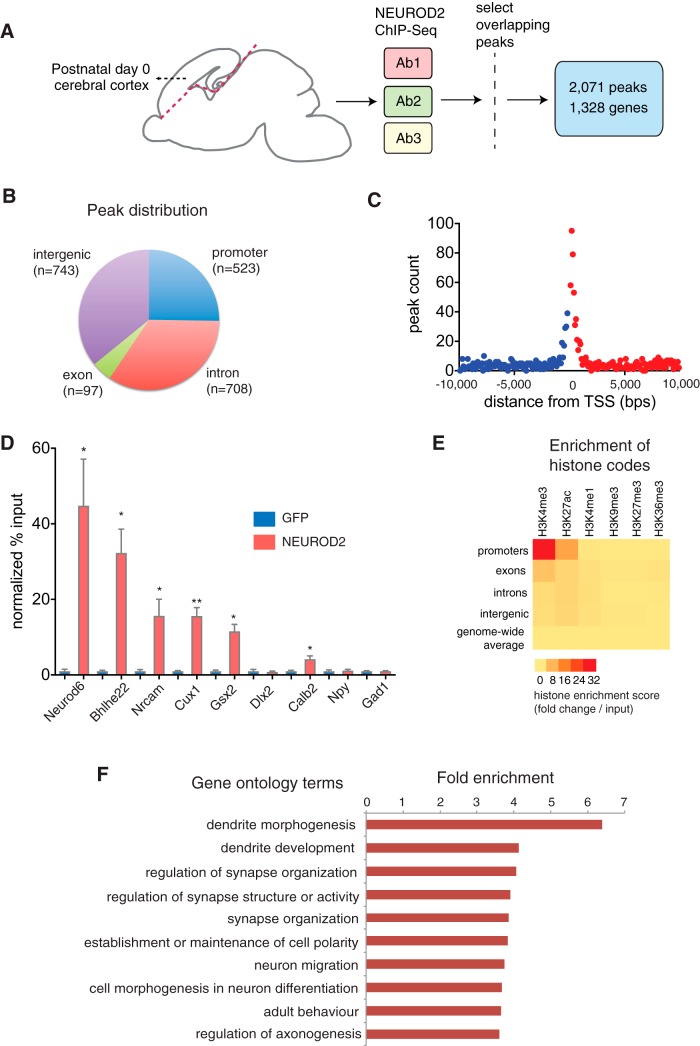
Identification of genome-wide NEUROD2 binding sites at postnatal day 0 cerebral cortex. A, NEUROD2 ChIP-Seq was performed on cerebral cortex tissue using three separate antibodies. Selecting for overlapping peaks in all three datasets revealed 2,071 high confidence binding sites mapping to 1,328 annotated genes. B, Distribution of midpoints of NEUROD2 binding sites based on mouse Ensembl transcripts. Midpoints mapping within ± 1000 bp of TSSs are accepted as promoter binding. C, The number of NEUROD2 binding regions is plotted as a function of the distance of their midpoints to the closest TSS. A clear binding preference for NEUROD2 within ± 1000 bp is observed. D, Quantification of NEUROD2 binding to target and nontarget regions by ChIP-qPCR. Template DNA is immunoprecipitated with NEUROD2 antibody or an unrelated GFP antibody as a negative control. Amount of DNA immunoprecipitated is expressed as percentage of input DNA (% input). NEUROD2 % input values are normalized to GFP % input values as described in Materials and Methods. Enrichment of NEUROD2 is detected at target regions located on Neurod6, Bhlhe22, Nrcam, and Cux1 genes, but not at nontarget regions on Dlx2, Npy, and Gad1 genes. Slight enrichment is also observed in nontarget genes Gsx2 and Calb2. Bars represent SEM. p < 0.0001 determined by one-way ANOVA followed by unpaired t test, *p < 0.05, **p < 1 × 10−4 (Table 2). E, Enrichment of histone marks within NEUROD2 peaks located within different genomic regions is represented as a heat map. Genome-wide enrichment of histone marks, including NEUROD2 target and nontarget sequences, are plotted as baseline controls. F, Gene ontology analysis of all 1,328 genes identifies dendrite morphogenesis and synaptic organization as the two main NEUROD2-regulated biological processes. Significantly enriched GO categories (p < 0.01) are ranked based on their fold enrichment.